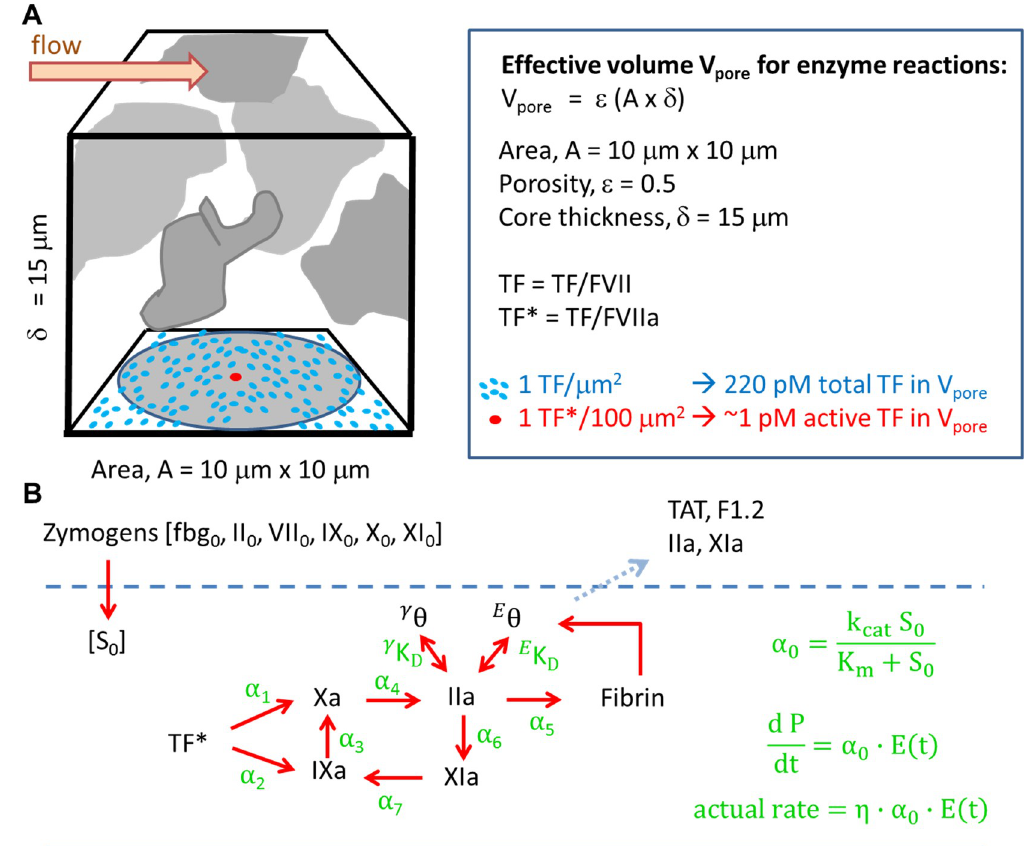
Fig 1. Schematic of the simplified ODEs model. The concentration of active TF � is defined as TF/FVIIa which is homogenized over the porous core volume V pore (A). All zymogens were assumed to enter the clot core by diffusion to maintain their plasma level [S] o . All active enzymes had a 1-minute half-life, with TF � set to 3 min (since FVIIa generation was ignored). Free thrombin and FXIa eluted by diffusion from the core with a 2-sec half-life. The thrombin core thickness was set to 15- μ m, with 50% of platelets by vol. Only the activated proteases are shown for